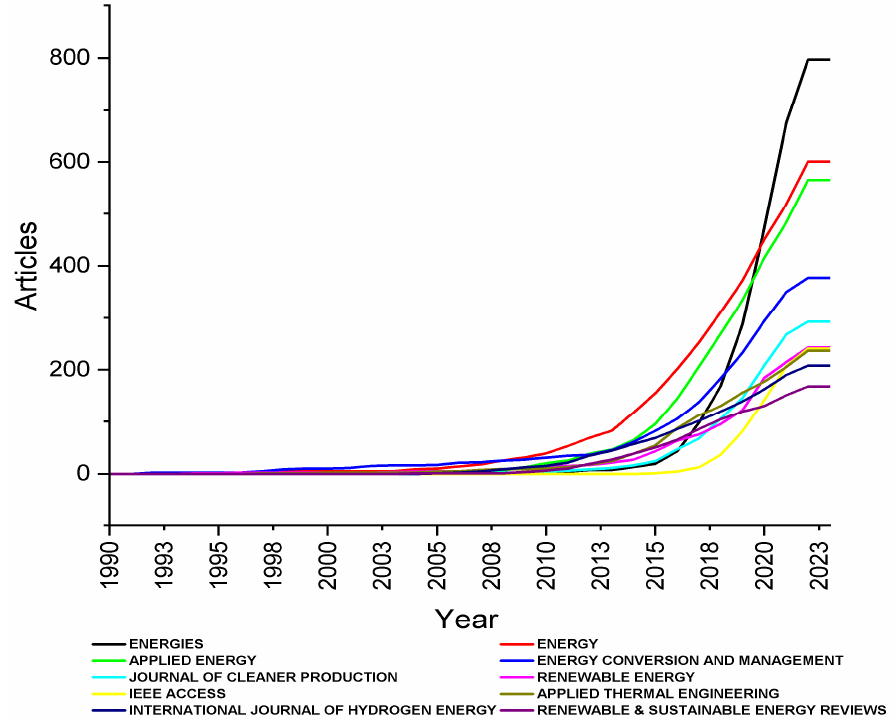
Figure 5. Source documents by year.